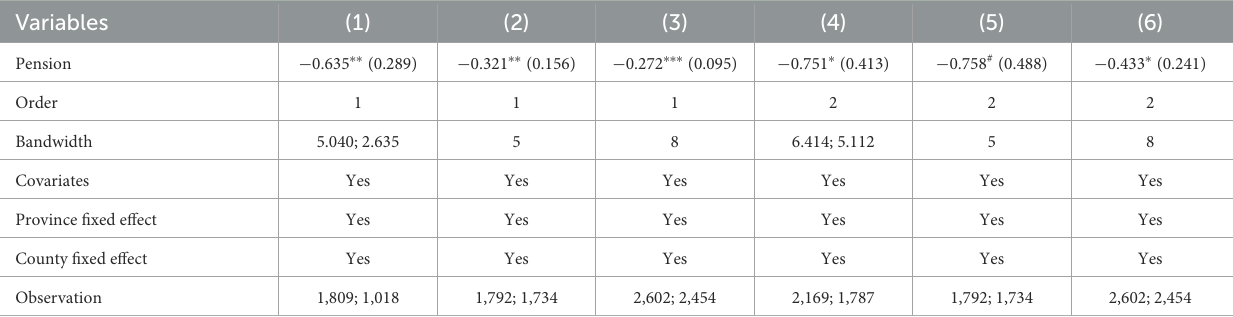
TABLE 6 Regression tests with different bandwidths and orders.